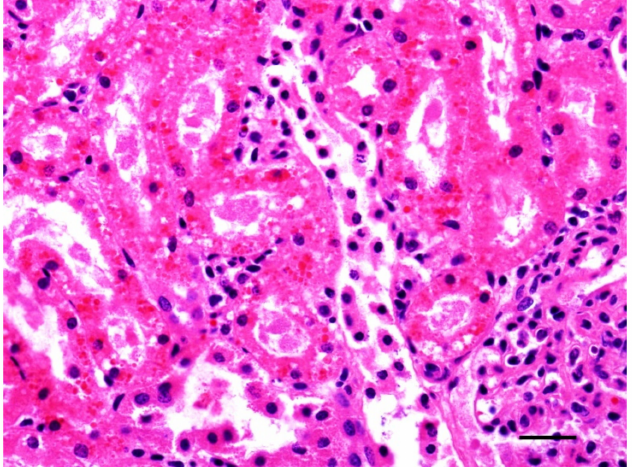
Figure 6. Kidney of a lamb with yellow lamb disease showing hemoglobinuria-associated acute tubu- lar injury. The renal cortical tubular epithelial cells are laden with variably-size, round, eosinophilic intracytoplasmic hyaline protein droplets. Hematoxylin and eosin. Bar = 60 µ